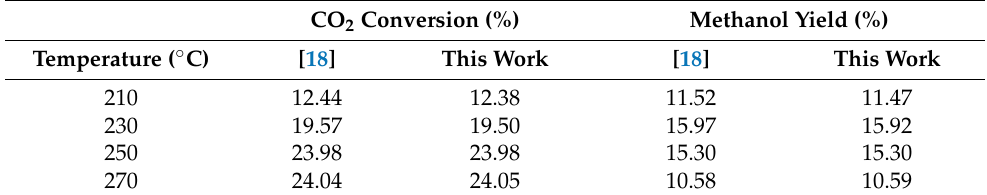
Table 1. Comparing simulation results between the reference data and the model by varying the reaction temperature at 50 bar, 5900 (mL/gcat · h).